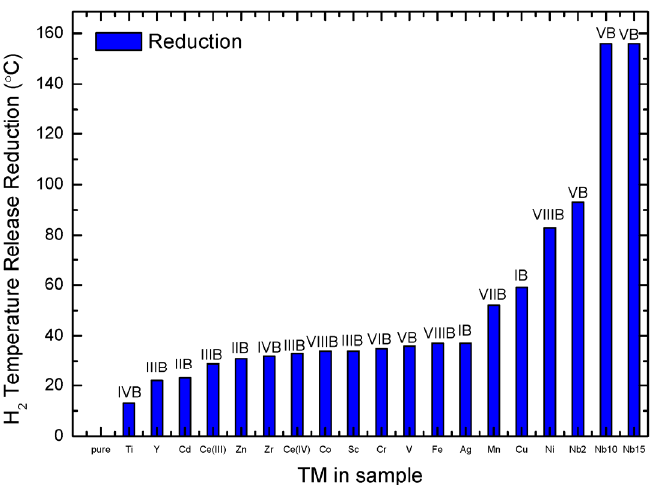
Figure 11. Temperature difference between the main decomposition peak of the samples with additives and the one of pure NaBH 4 , observed by TPD. Reproduced with permission from [171].